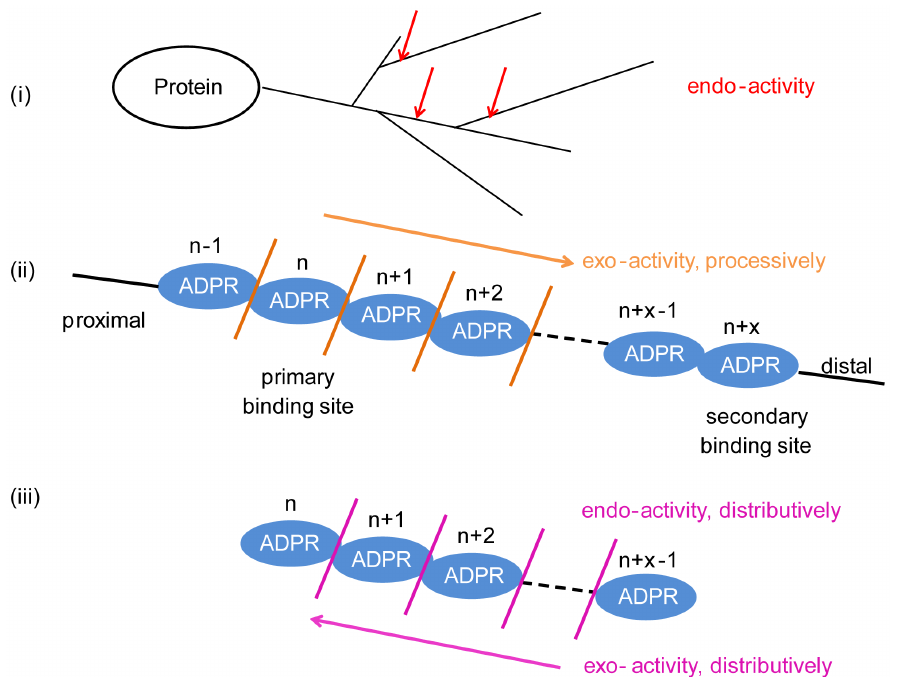
Figure 5. A model for different modes/stages of PAR degradation by PARG. Based on the data from this study and previous studies, we propose the catalytic mechanism of PAR degradation by PARG. In the early stage, PARG randomly recognizes the PAR between (n-1) and (n) ADPr, then hydrolyzes the glycosidic bond in-between (endo- activity). Because the (n-1) PAR polymer has lower binding affinity, it leaves PARG after the reaction. Long PAR polymers may have higher affinity with PARG than short PAR, due to the interaction between the (n + x) ADPr unit and the potential secondary iso -ADPr binding site. The (n + ) PAR polymer stays with PARG after cleavage. Thereafter, PARG can slide along the (n + ) PAR polymer to cleave ADPr units from proximal to distal end one by one (exo- activity). In the late stage, when the PAR polymer is not long enough, which result in the lower binding affinity with PARG (no secondary binding site), PARG can no longer processively degrade PAR polymers. Shorter PAR leaves PARG after every single cleavage, and is degraded by PARG